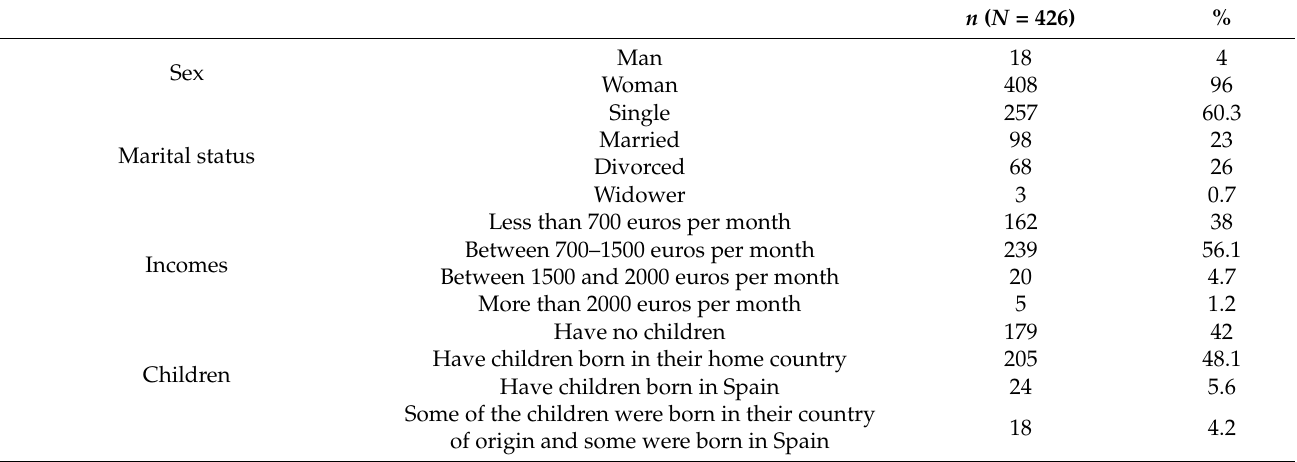
Table 1. Descriptive analysis of qualitative